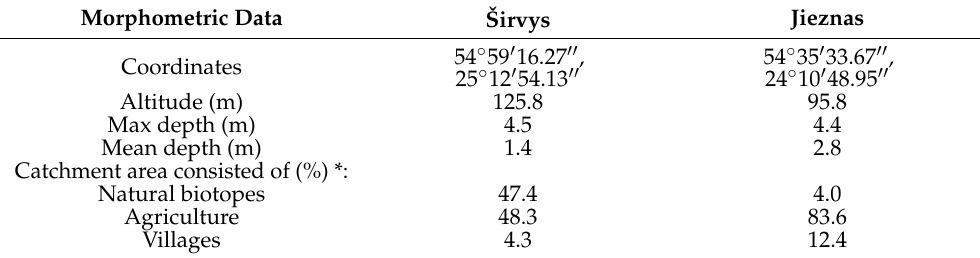
Table 1. Morphometric characteristics of the studied lakes and land use of their catchment area. Morphometric